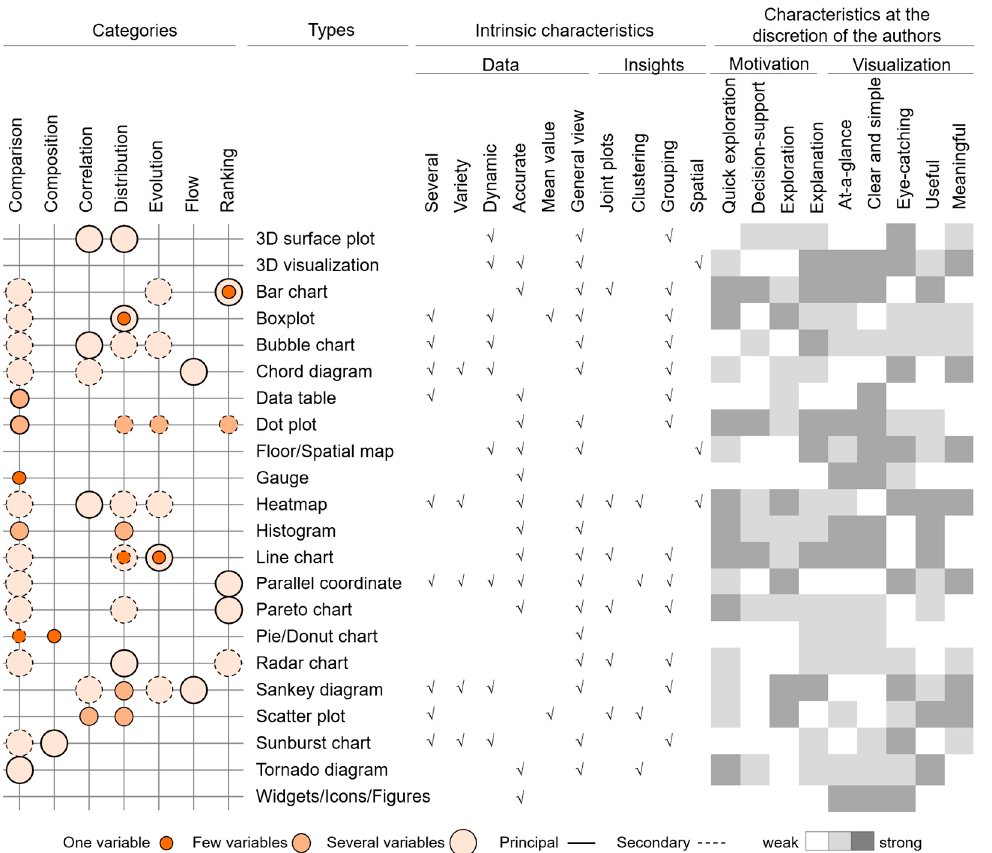
Figure 2. Most commonly used types of graphical representation of data in scientific literature, IoT platforms, and visualization software in relation to functional categories and characteristics.